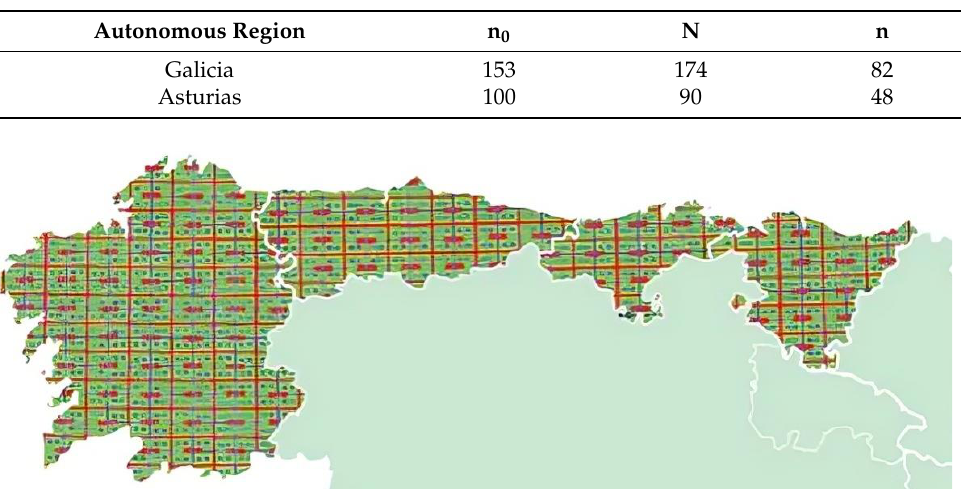
Table 2. Optimum sampling points by Autonomous Region.